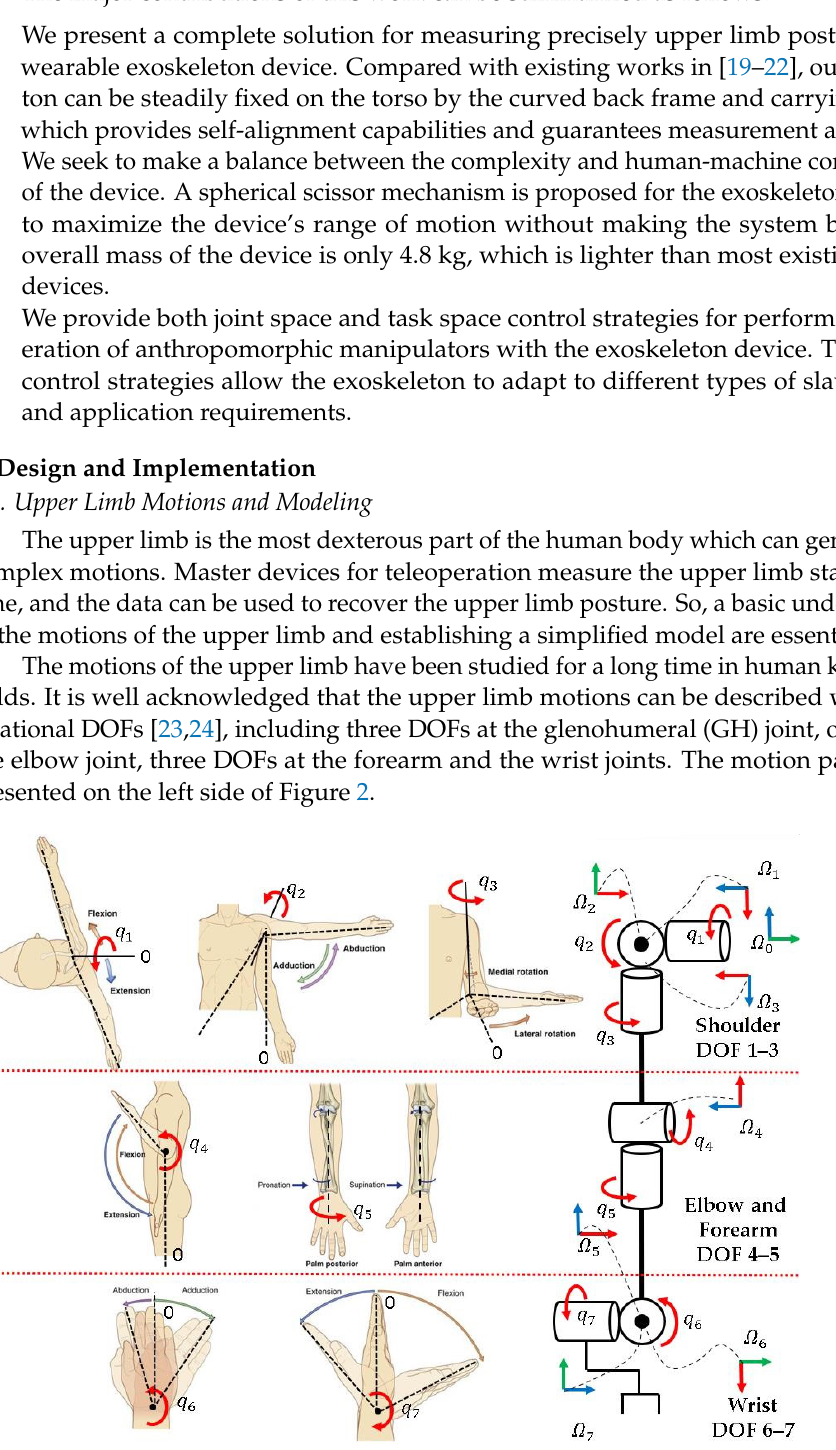
Figure 1. The wearable upper limb exoskeleton system.